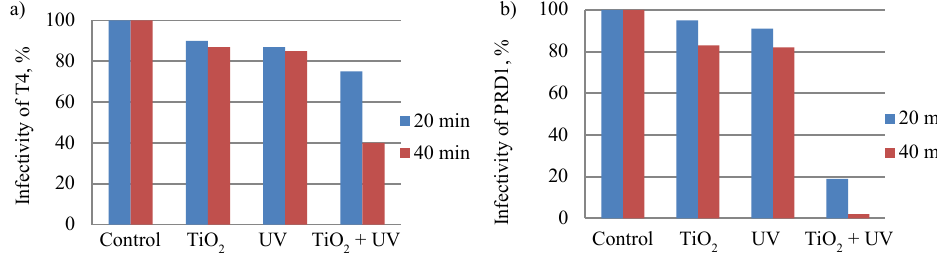
Fig. 3. Infectivity of bacteriophages T4: a) and PRD1, b) after the treatment in the mixture. The experiments were performed at 22 °C, the initial number of T4 and PRD1 was 1×10 4 pfu/mL, 1 mg/mL of TiO 2 and intensity of UV irradiation 2 mW/cm 2 were applied.